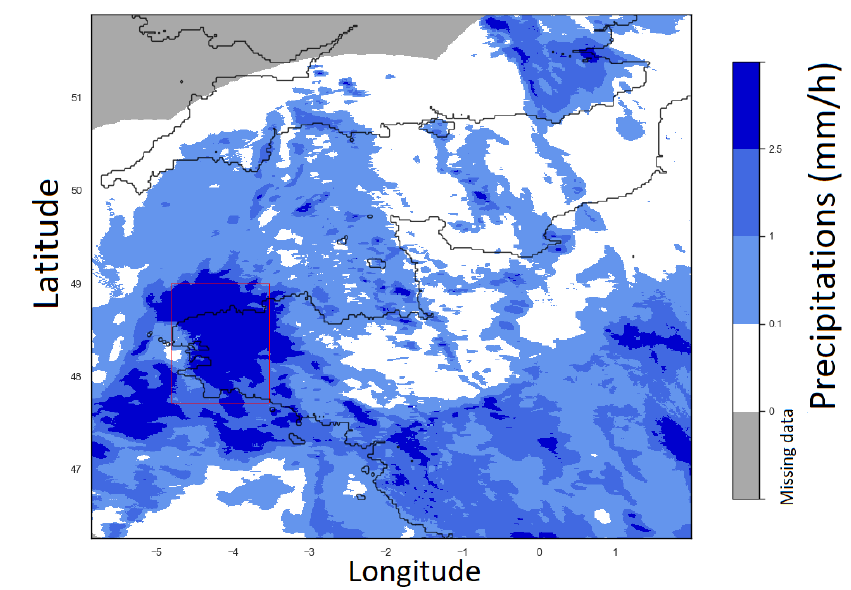
Figure 1. An example of rain radar image acquired on the 7 January 2016 at 02:25:00 in the North West of France with the study area framed in red. Precipitations are colored in blue scale corresponding to the classes thresholds defined in Table 1. Gray corresponds to missing data.